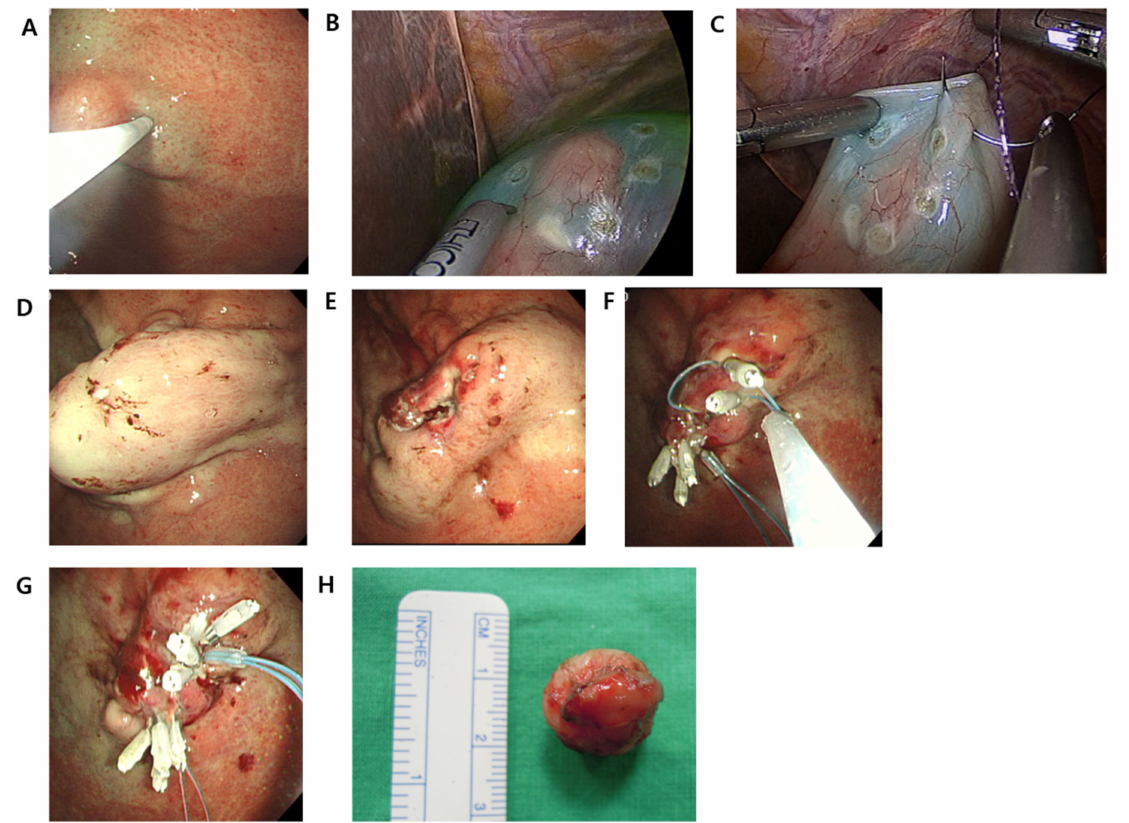
Figure 2. The nonexposure simple suturing endoscopic full-thickness resection (NESS-EFTR procedures). ( A ) Endoscopic saline injection around the tumor. ( B ) Laparoscopic serosal marking. ( C ) Laparoscopic seromuscular suturing. ( D ) Endo- scopic view after serosal suturing. ( E ) Completion of endoscopic full-thickness resection. ( F ) Endoscopic suturing using endoloops and clips. ( G ) Completion of endoscopic suturing. ( H ) Resected